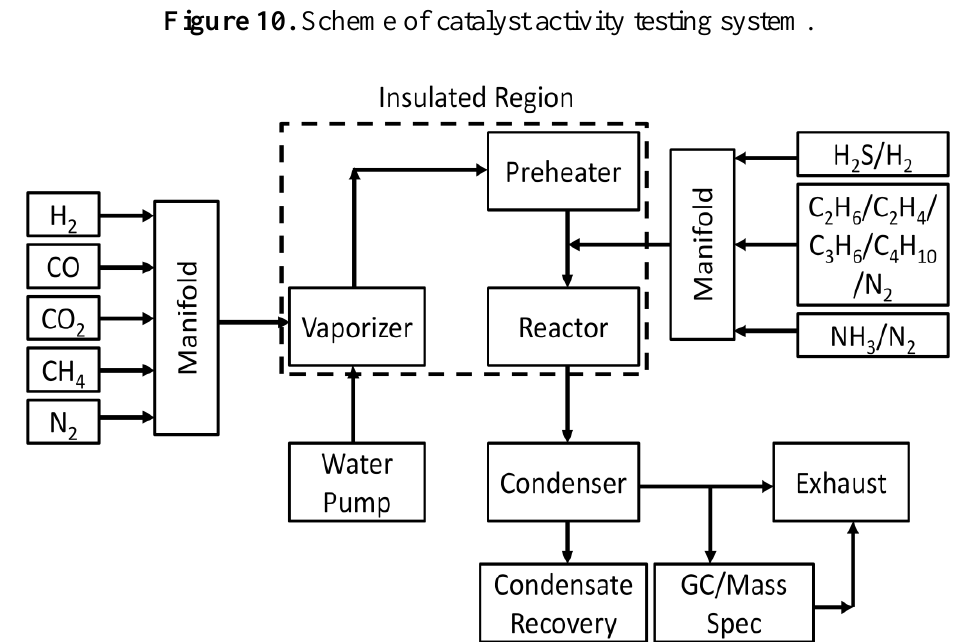
Figure 10. Scheme of catalyst activity testing